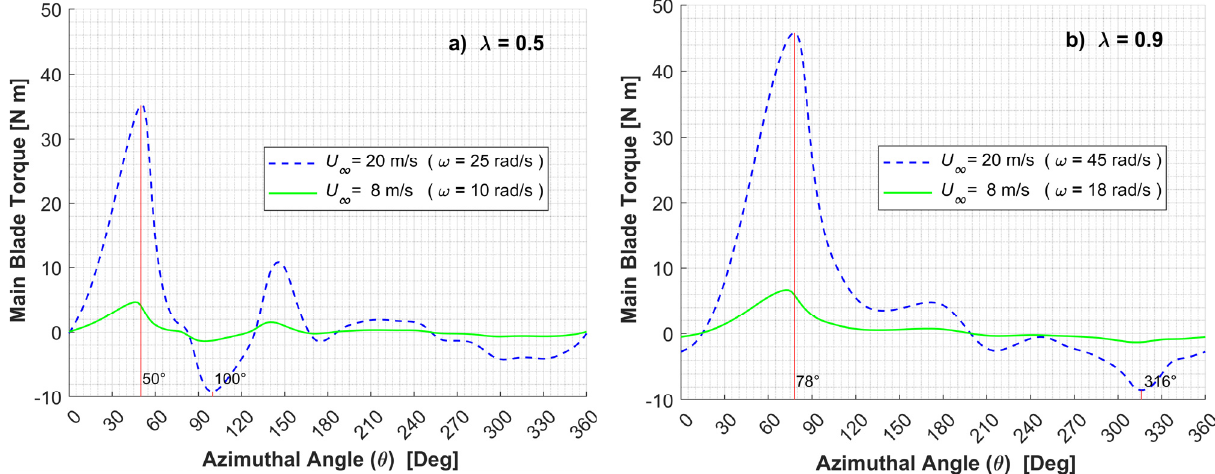
Figure 14. Torque on Blade 1 at Various Azimuthal Angles, for U ∞ = 8 m/s and U ∞ = 20 m/s at: ( a ) λ = 0.5 and ( b ) λ = 0.9, Using the 2D Model of the Present Study.